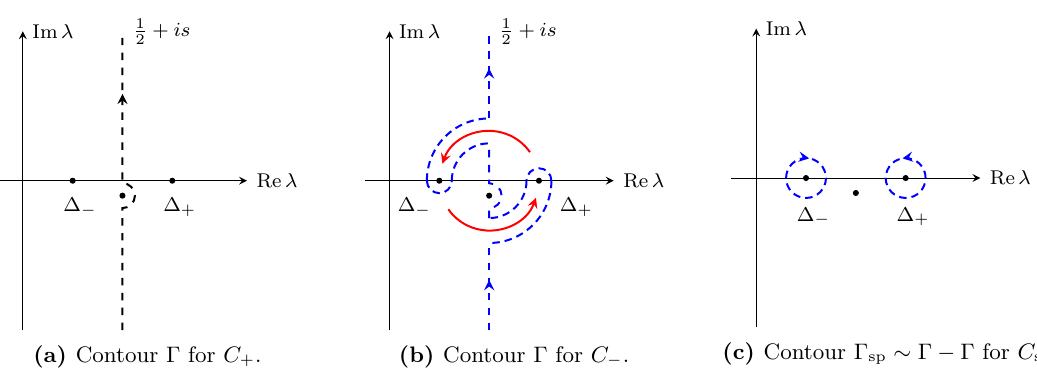
Figure 10. Switching the boundary condition from Dirichlet to Neumann amounts to exchanging the poles (cid:1) (cid:0) and (cid:1) + . The procedure should be accompanied by a deformation of the integration contour as shown in (b). The di(cid:11)erence contour (cid:0) (cid:0) (cid:0) is homologous (in the complement of singularities) to the one shown in